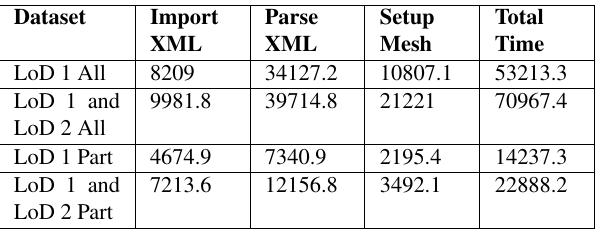
Table 5: Results - All Times in milliseconds ing (e.g. to change activity from download to rendering), and all times are measured in milli-seconds.